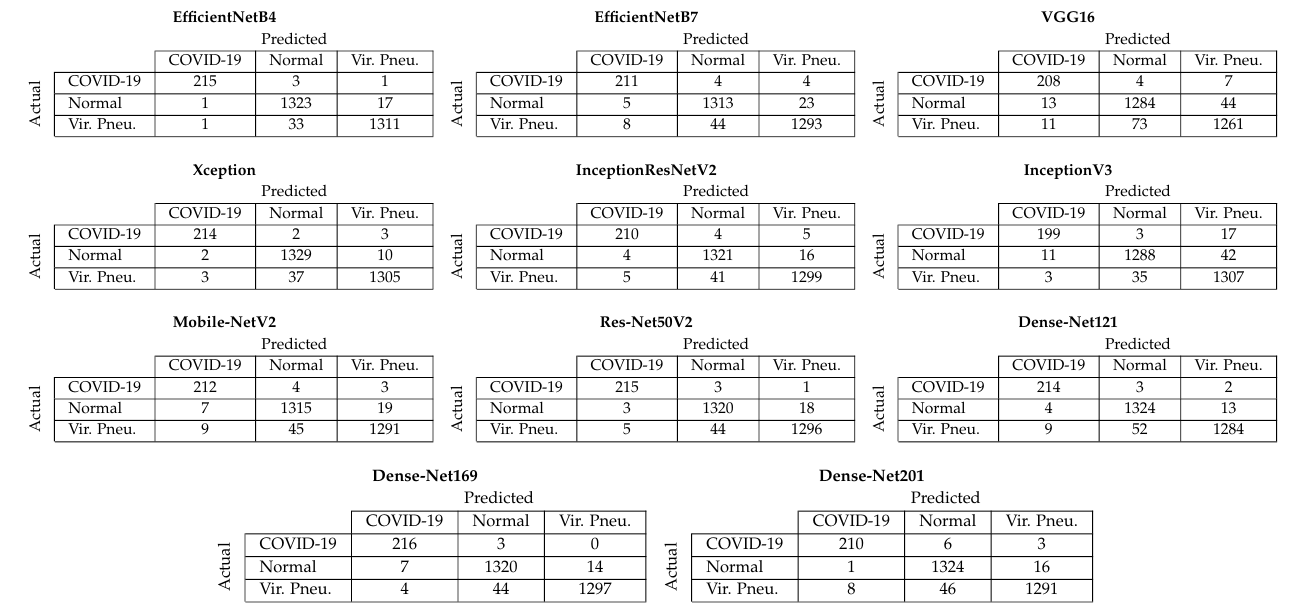
Figure 4. Aggregated confusion matrices for Approach 1 (end-to-end training)